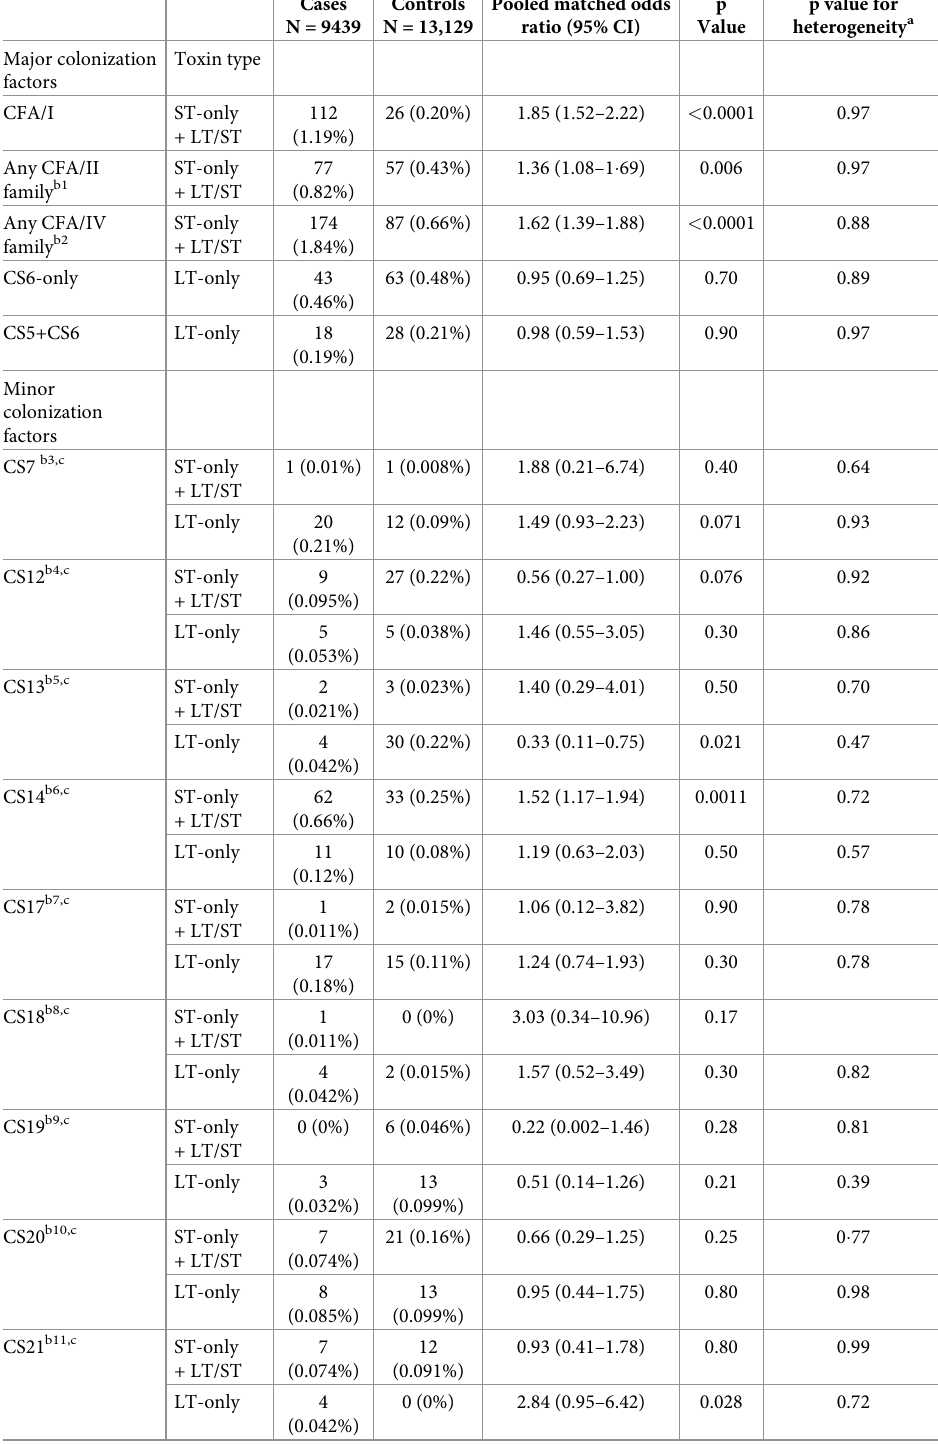
Table 6. Odds ratios for association with moderate-to-severe diarrhea of ETEC encoding major or minor coloni- zation factors in combination with different toxin